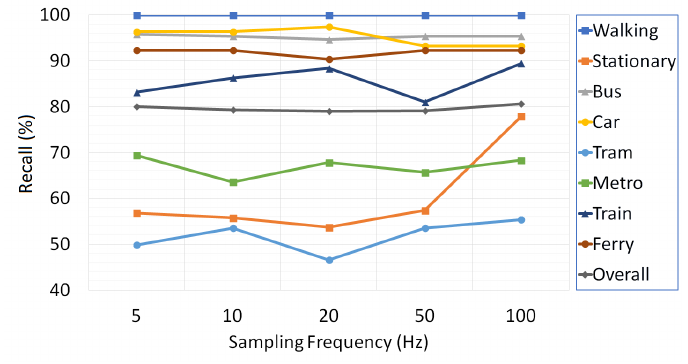
Figure 6. The effect of sampling frequency on the classification results.